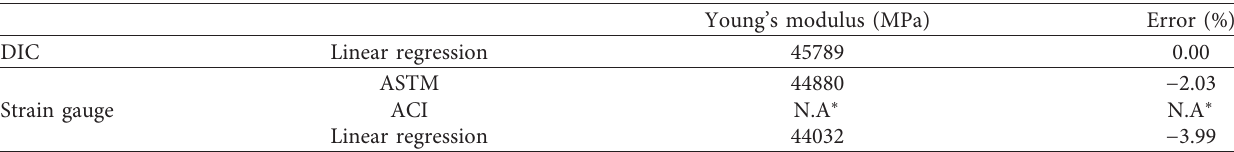
Table 4: Young’s modulus comparison of